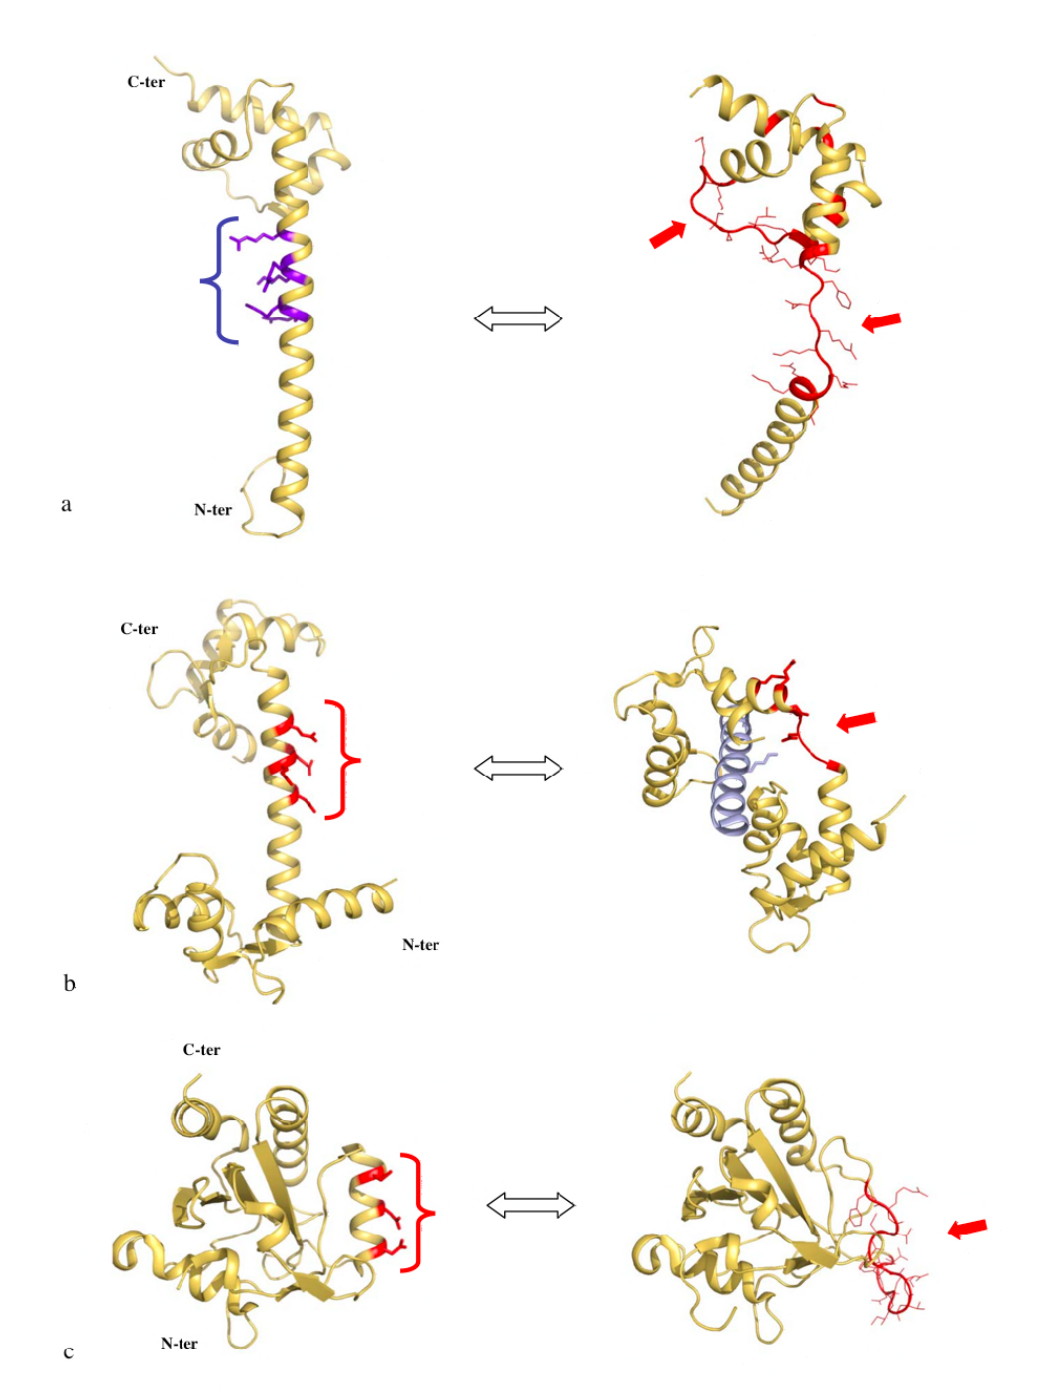
Figure 6. Charge repulsion and unwinding of α -helices. Comparison of the folded (left) and the partially unfolded (right) forms of L20 (2GHJ)(a), calmodulin (1CCL and 2IX7) (b) and poplar thioredoxin (2P5Q and 2P5R)(c). The cluster of charged residues are indicated by parentheses. The unfolded regions are indicated with an arrow. In each case, the electrostatic repulsion between the side chains of the charged residues is thought to be responsible for the helical unwinding. The unfolded form of L20 is stabilised through intermolecular contacts with the folded form in the crystal packing (Figure